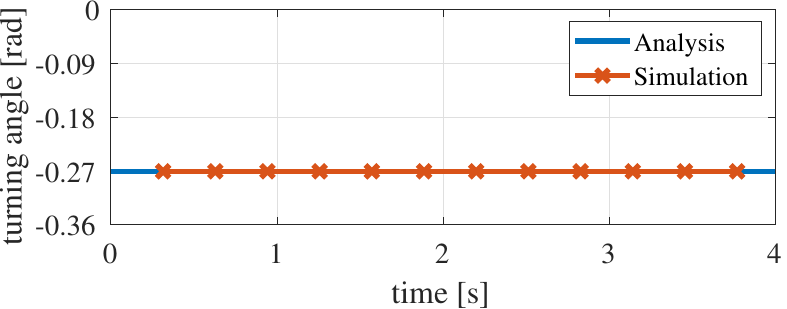
Figure 9. The time variation of the turning angle in the simulation for clockwise turning locomotion. Since the turning angle indicates − 0.27 rad, the simulation results show that the robot turns to the right by setting β = − π